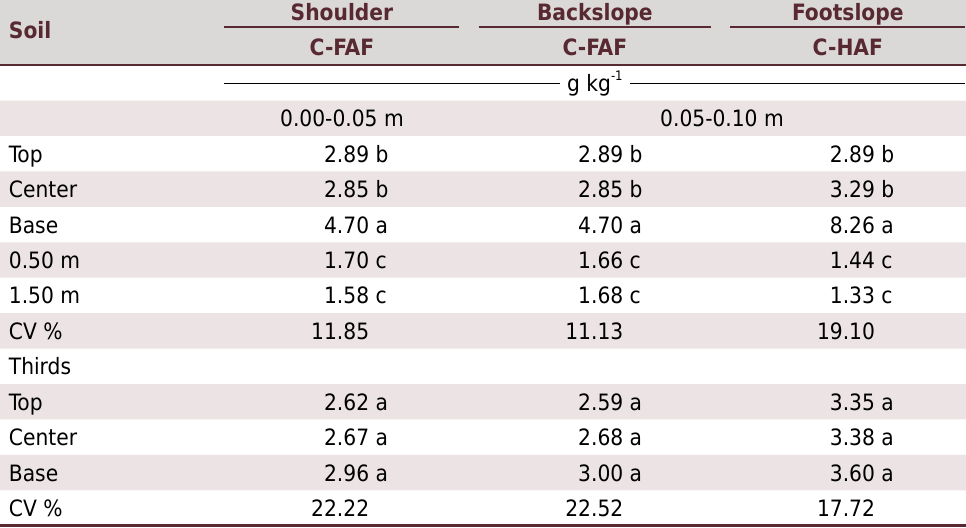
Table 7. Carbon content fulvic acid fraction (C-FAF) in termite mounds and adjacent soils in the Mar de Morros region, Municipality of Pinheiral, Rio de Janeiro State